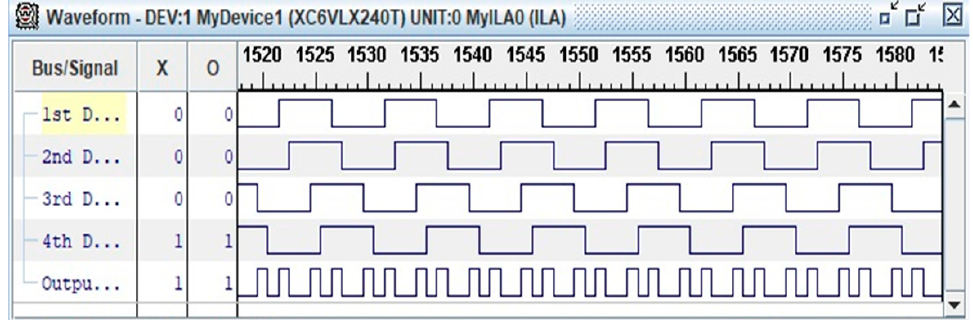
Figure 13. Waveform from ChipScope Pro Analyzer function.